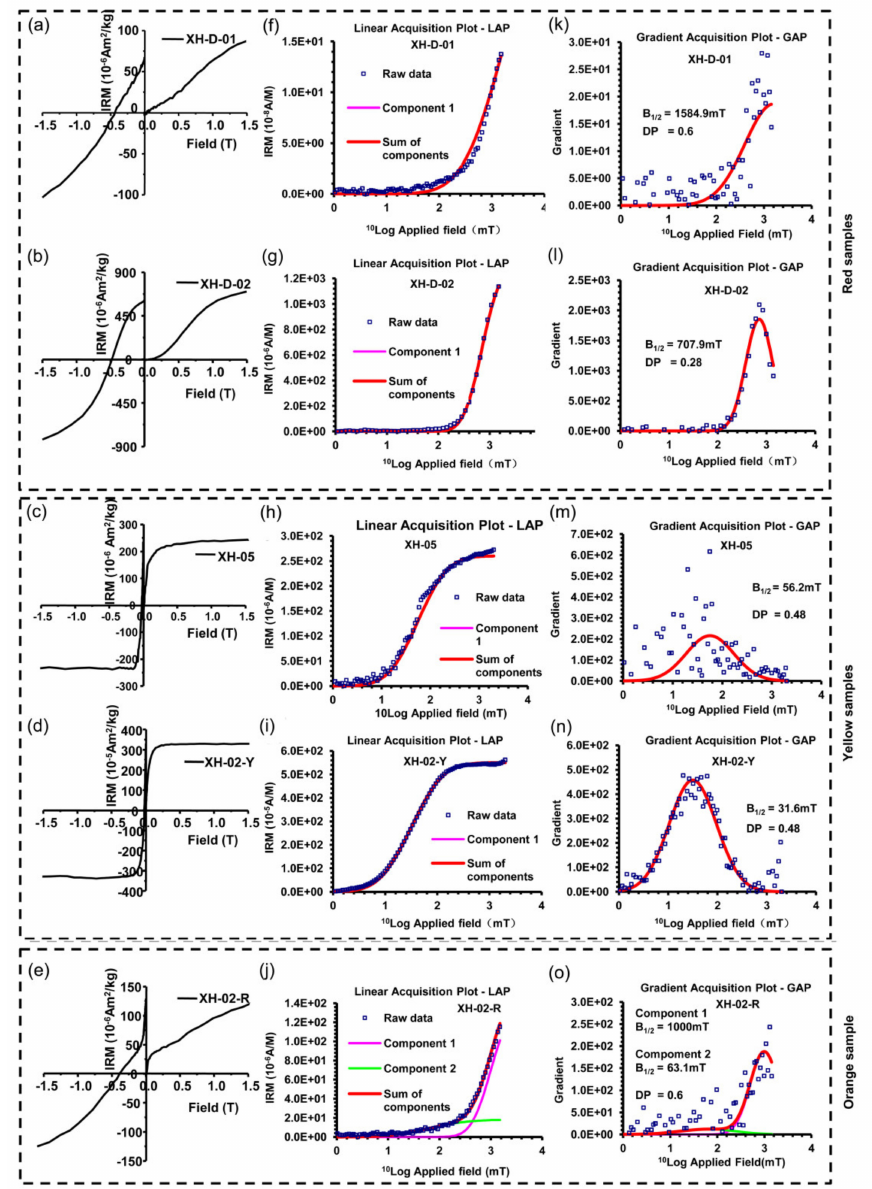
Figure 6. The acquisition curves of isothermal remnant magnetization (IRM) and their back-field demagnetization ( a – e ), linear acquisition plot (LAP) ( f – j ) and gradient acquisition plot (GAP) ( k – o ) of investigated